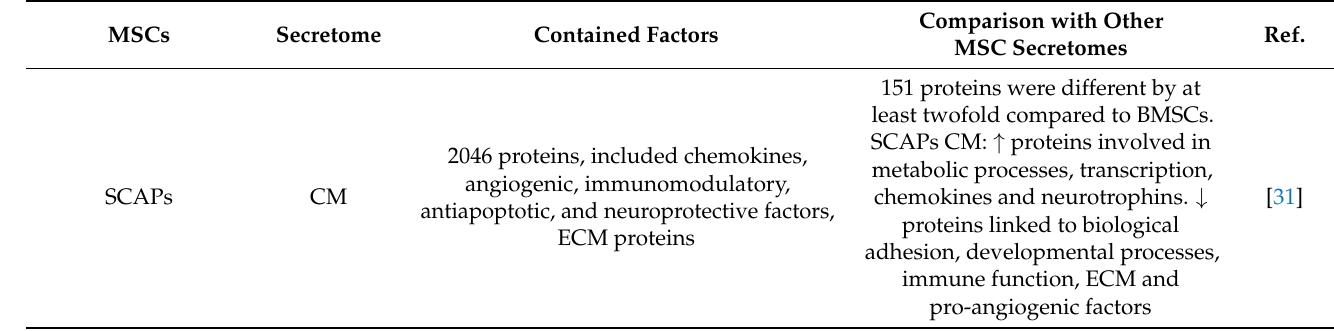
Table 1. Overview of the main factors found in the dental MSC